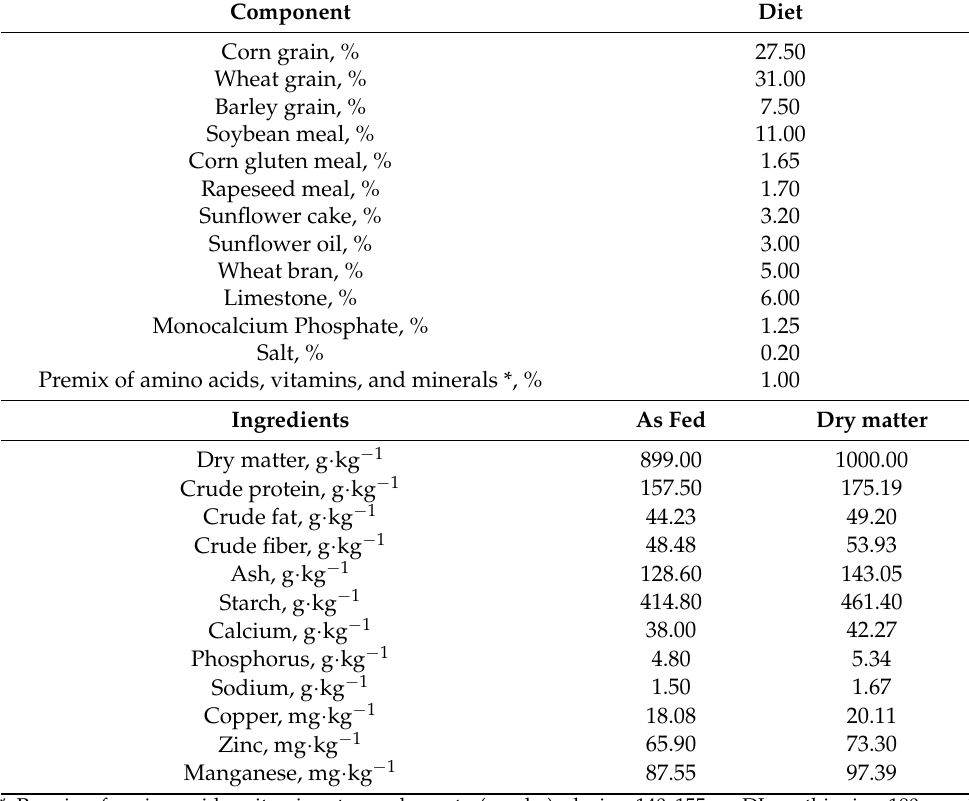
Table 1. Components and nutritional composition of laying hen